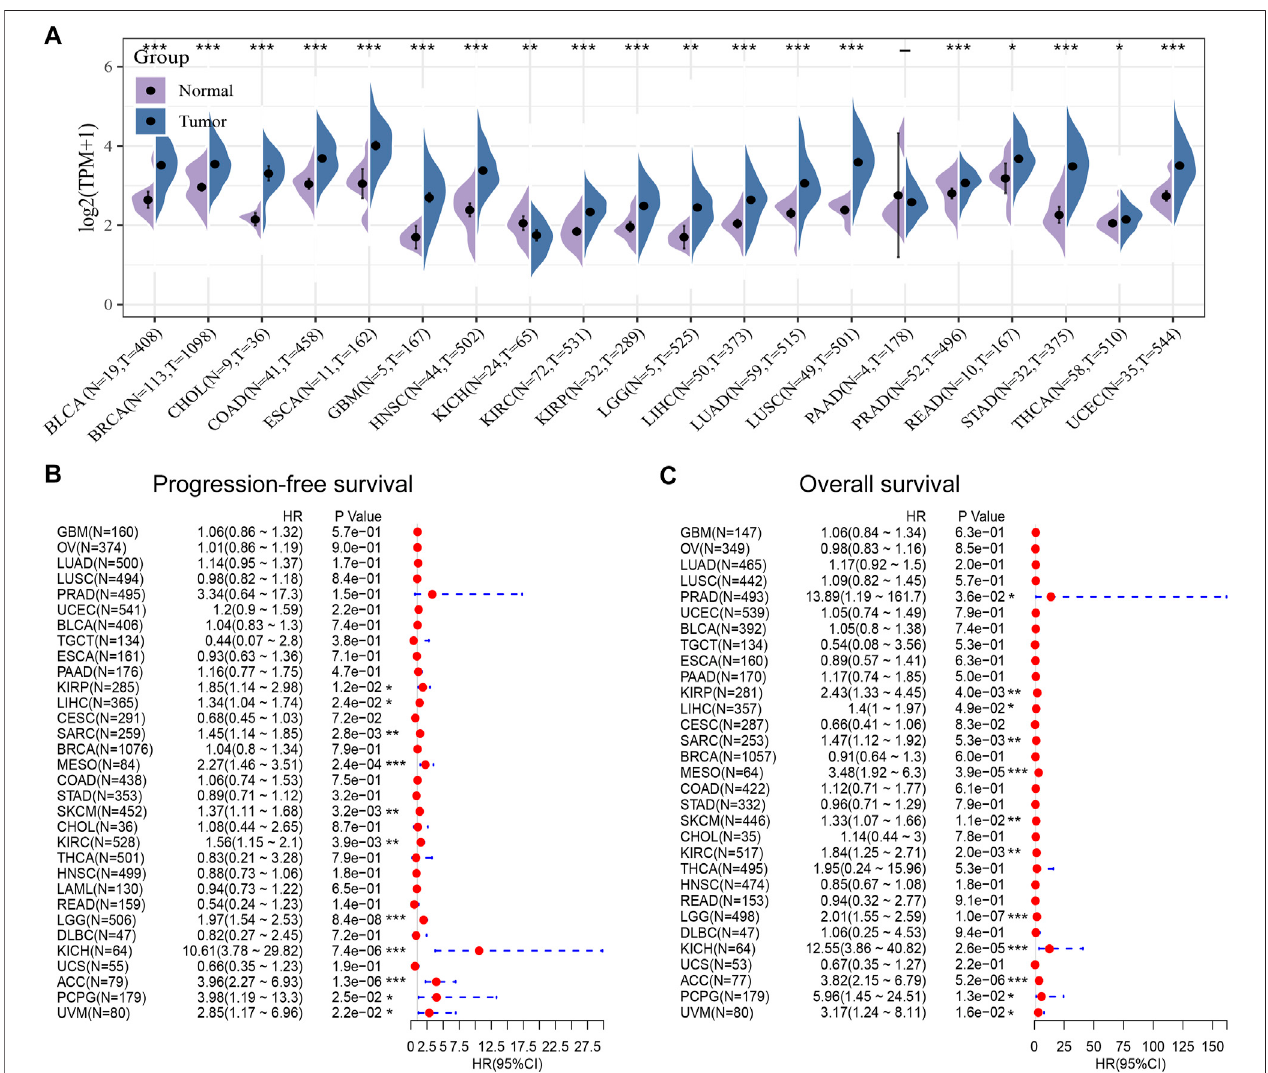
FIGURE 3 | High expression of polymerase epsilon (POLE) in pan-cancers compared with adjacent normal tissues. (A) POLE expression levels between pan- cancerandnormaltissuesbasedonTheCancerGenomeAtlas(TCGA)data.ThedifferentialexpressionofPOLEbetweencancertissueandadjacentnormaltissuewas common in pan-cancer, and the expression of POLE was mainly higher in tumor tissue. (B, C) Cox regression analysis suggests that POLE expression is closely linked with overall survival (OS) in many